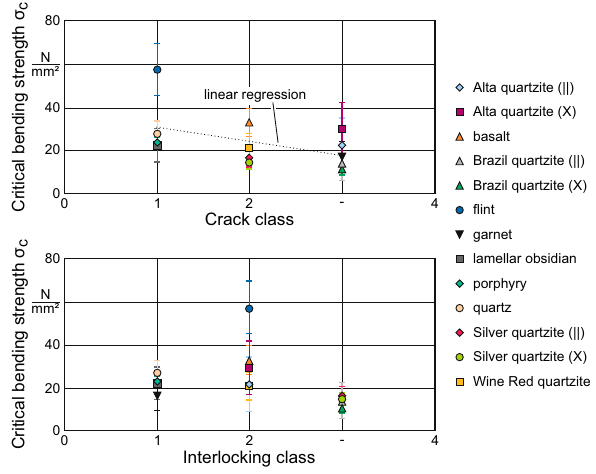
Fig. 9 Influence of crack and interlocking class on critical bending strength of the rocks